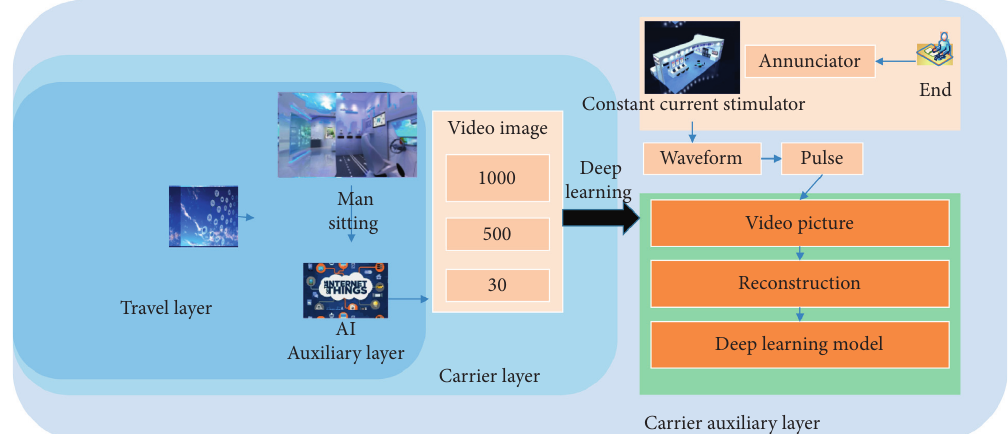
Figure 5: Scene view.